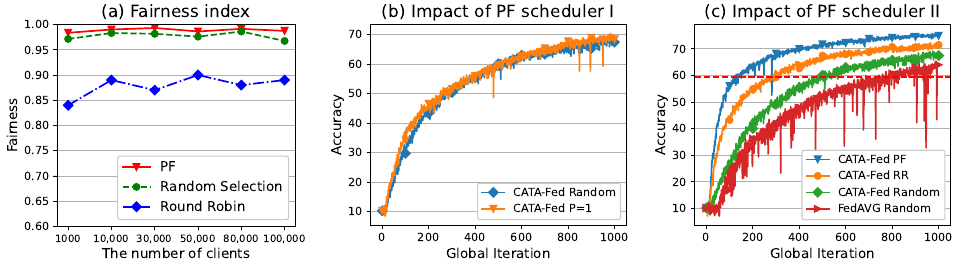
Figure 13. ( a ) The number of clients vs. fairness index of Raj Jain, ( b ) test set accuracy of CATA-Fed PF ( P = 1) vs. global iterations for CIFAR-10, and ( c ) test set accuracy of CATA-Fed PF ( P = 4) vs. global iterations for CIFAR-10 with deadline T = 1, the number of biased class H =